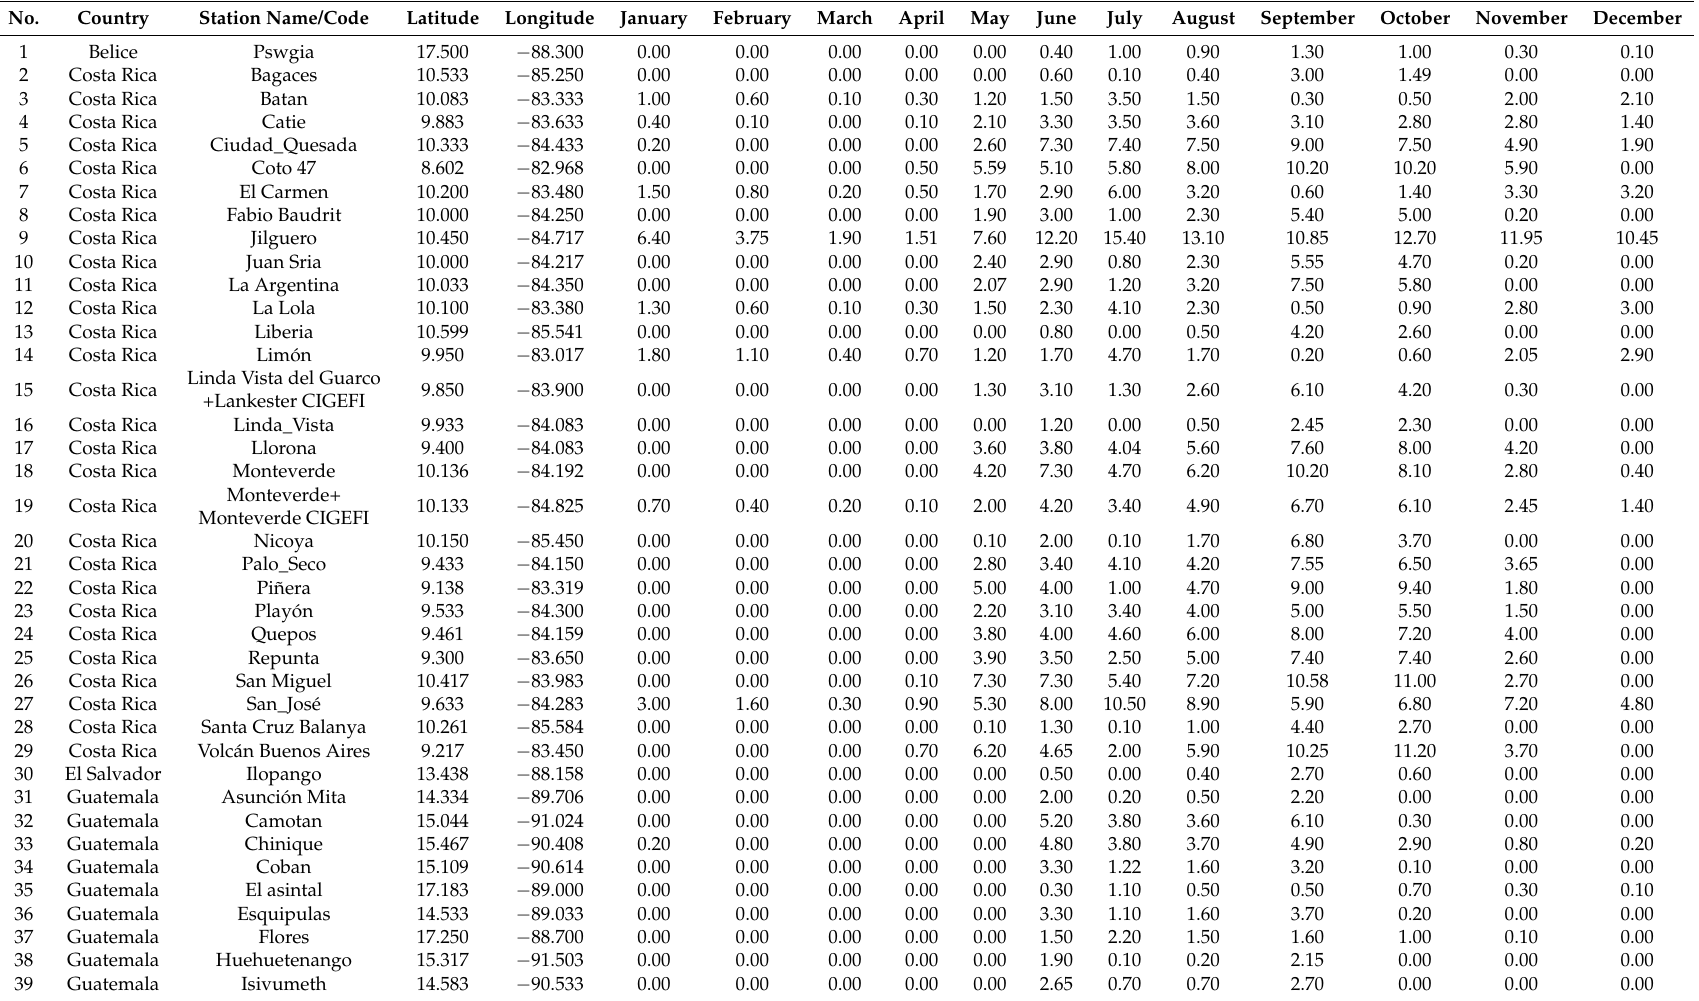
Table 1. Station metadata and median value [mm/day] by